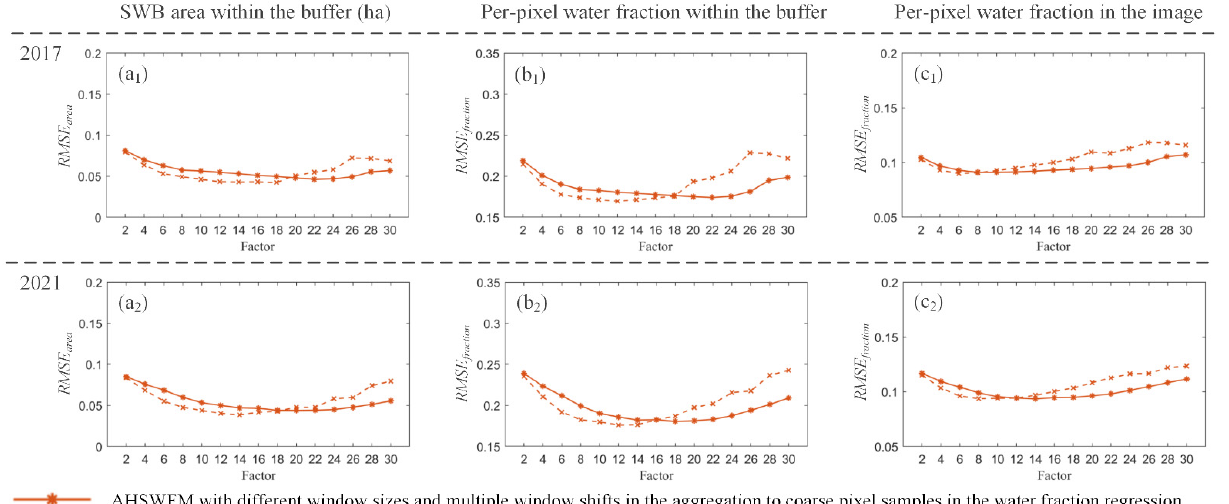
Figure 12. Accuracies in automated and hierarchical surface water fraction mapping (AHSWFM) with different window sizes and shifts in the aggregation to coarse pixel samples in the water fraction regression in AHSWFM. ( a 1 , a 2 ) RMSE area values in the estimation of small water body (SWB) area, ( b 1 , b 2 ) RMSE fraction values in the estimation of SWB fractions in the buffer and ( c 1 , c 2 ) RMSE fraction values in the estimation of SWB fractions in the entire image.